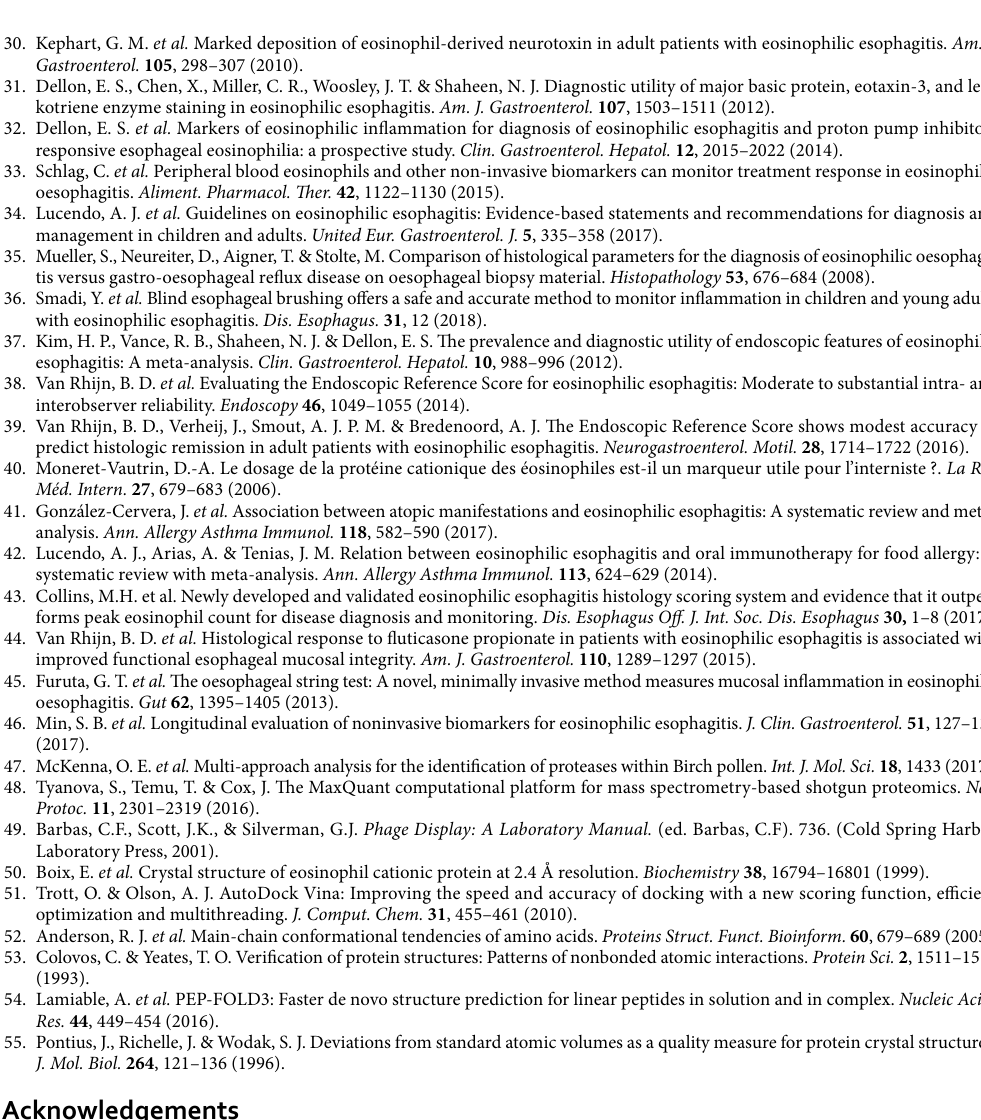
figure. P.B. and F.F. conducted the acquisition and analysis of Mass spectrometry data. All the authors gave final approval to the version